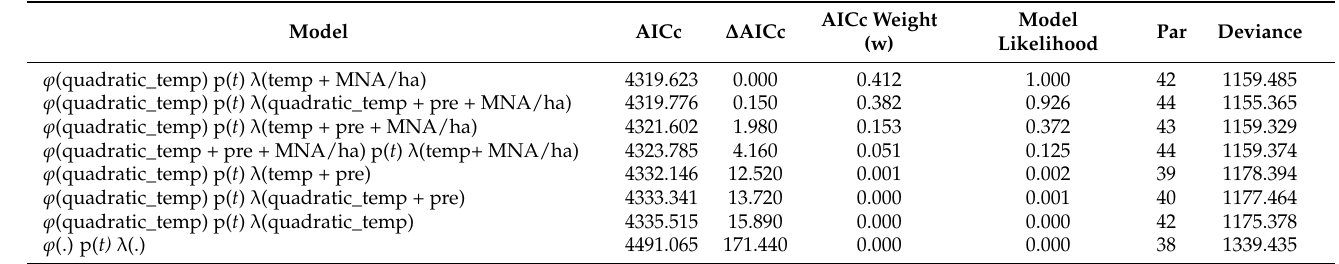
Table 2. Complex effects of temperature ( ◦ C), precipitation (mm), and population density on popula- tion growth rate ( λ ) using the Jolly-Seber models for Mongolian gerbils ( Merionus unguiculatus ) in